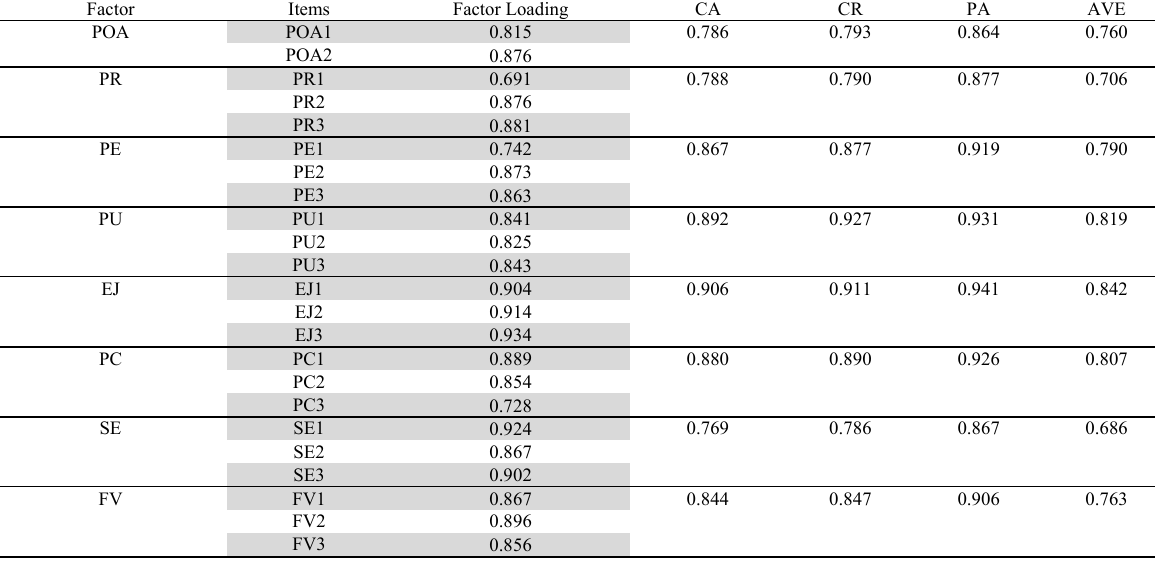
Measurement model